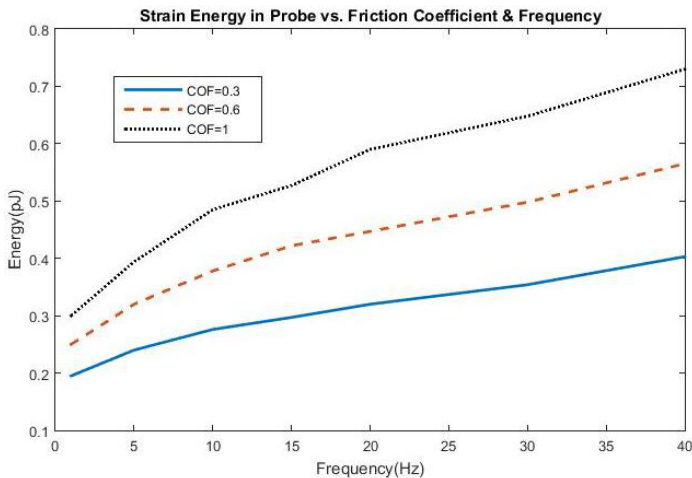
Figure 3. Strain Energy in the 200 kPa probe as a function of friction coefficient and frequency.